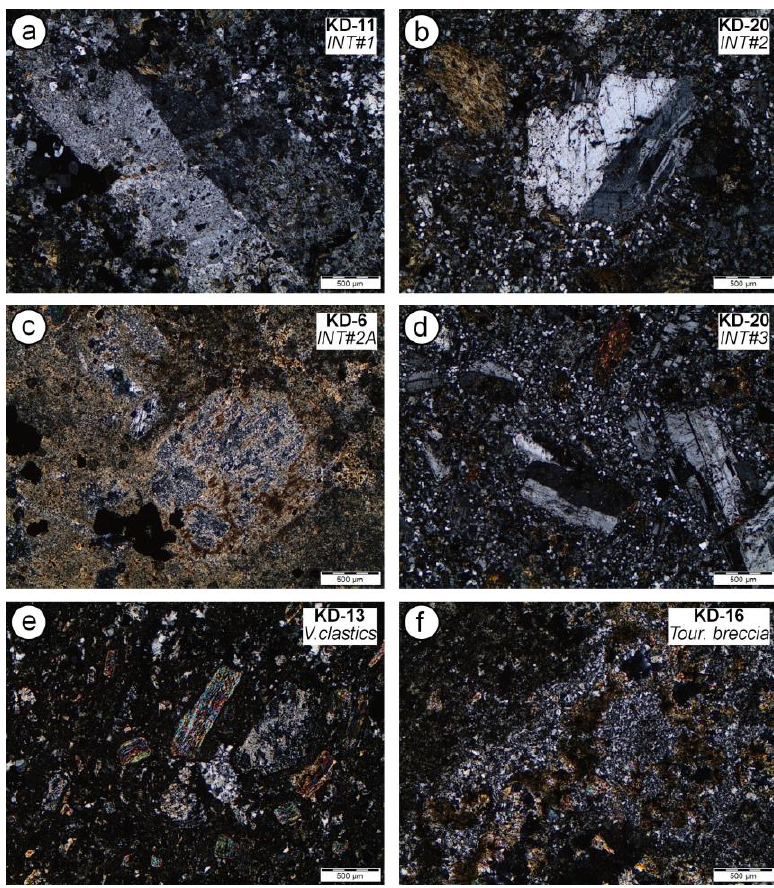
Figure 5. Optical microscopic photomicrographs of representative samples from different intrusions and volcanoclastic rocks. ( a ) Coarse-grained (megacryst) K-feldspar phenocryst within a silicified and hydrothermal biotite-bearing groundmass. ( b ) Poly-synthetic zoned plagioclase and biotite phenocrysts in a silica-rich groundmass. ( c ) Intensively sericitized and kaolinitized feldspar phenocrysts and groundmass with opaque minerals. ( d ) Euhedral poly-synthetic twinned plagioclase and partly-chloritized amphibole phenocrysts within the silicified groundmass. ( e ) Vitrophyric porphyritic pyroclastic rock containing silicified pumice and sericitized biotites within the devitrified volcanic groundmass. ( f ) Radial tourmaline occurrences and fine-grained quartz associations in the sample from the tourmaline breccia zone.